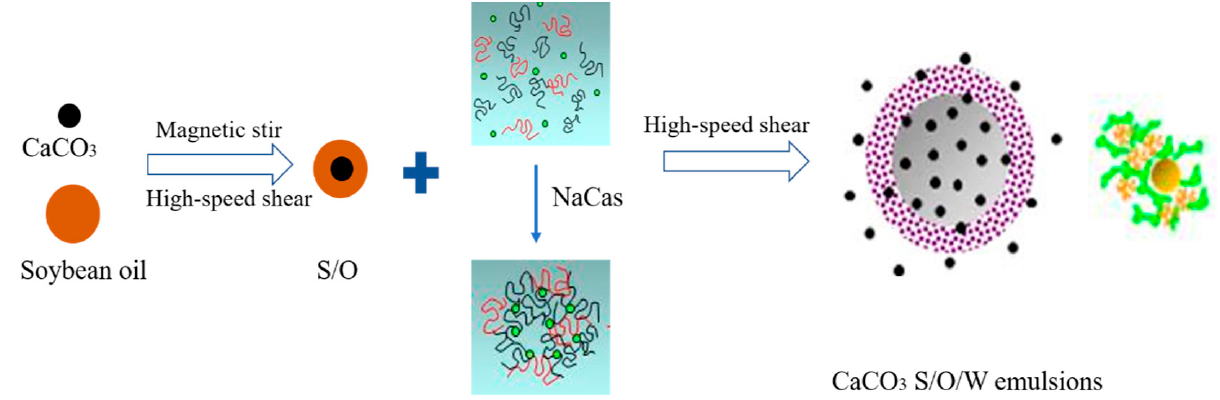
Figure 1. Schematic diagram of the preparation of S/O/W emulsion.